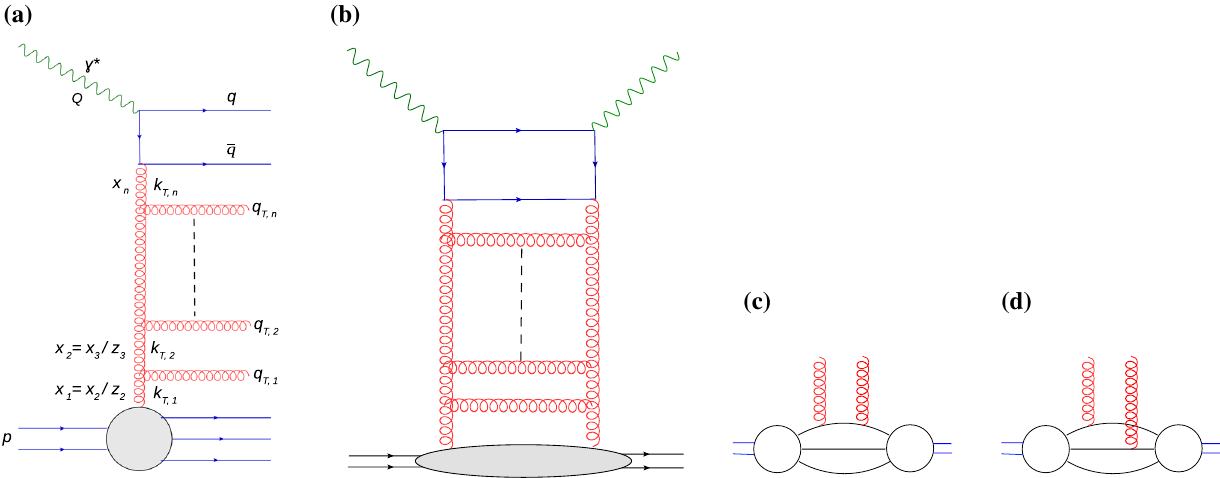
c , d Two simple examples of the inhomogeneous driving term of (10) whichcorrespondtotheshadedregionofgluon-virtual photoncoupling in